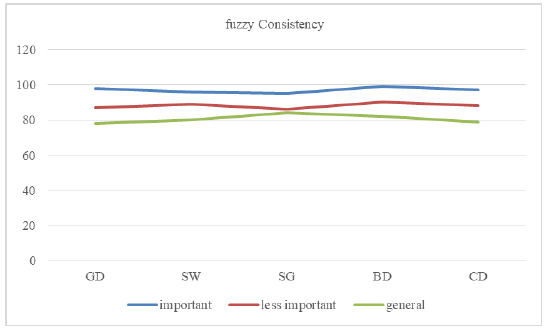
Figure 6 . Fuzzy Consistency Distribution